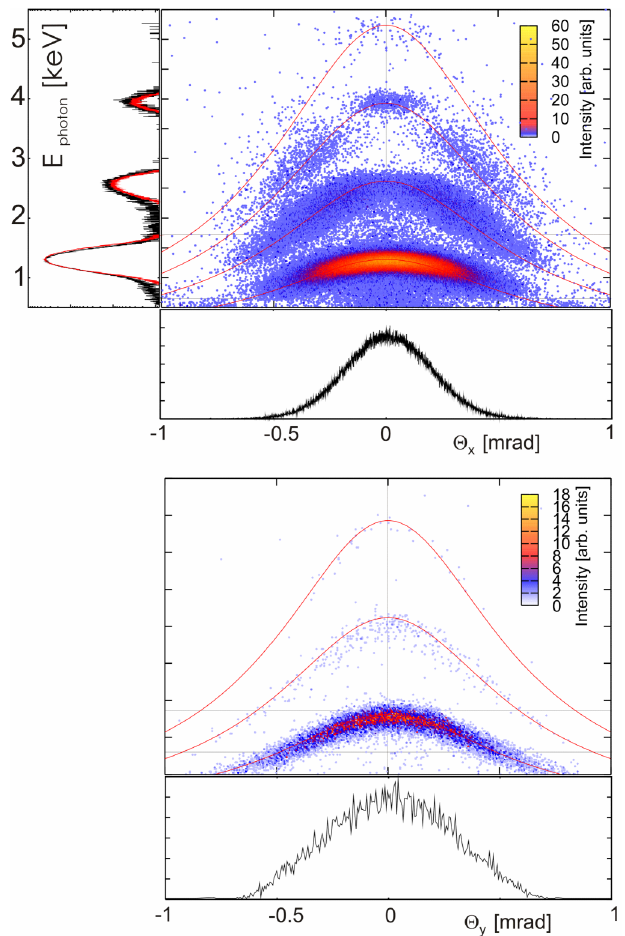
FIG. 6. (Color) Undulator radiation spectra as a function of the horizontal ( x ) and the vertical ( y ) observation angles (cid:5) , recorded with a Ge detector at an electron energy of 855 MeV at MAMI. The absolute on-axis yield for harmonics up to the third is compared to SPECTRA simulations [22] in the left graph (red line) including an energy resolution of 200 eV (FWHM). The angular spread, integrated between the thin horizontal lines, is depicted in the lower one. Solid (red) lines indicate the general (cid:3) 2 (cid:5) 2 dependence of the